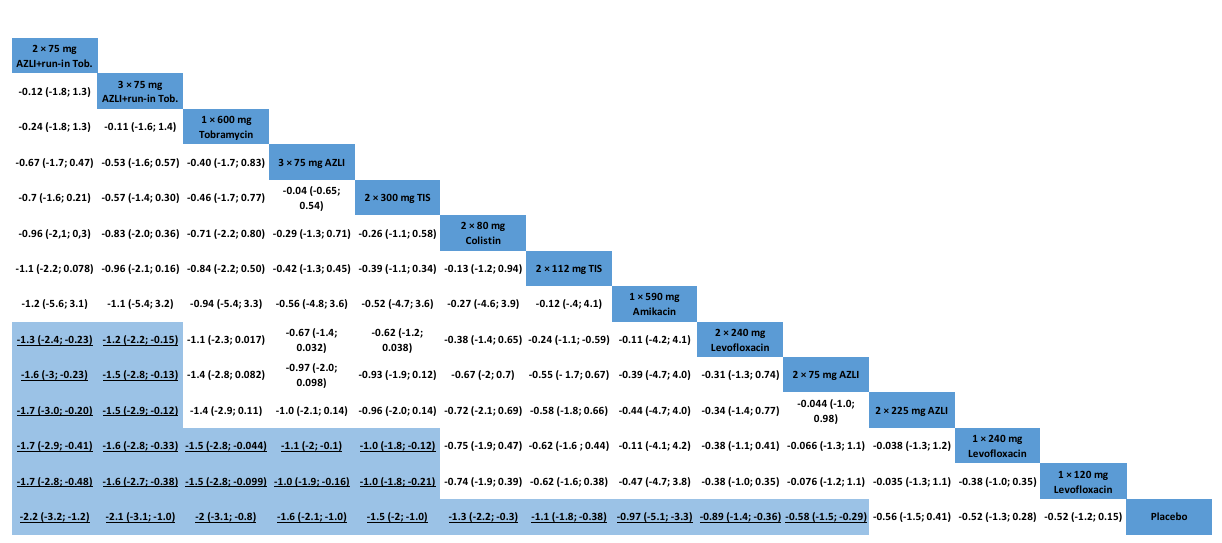
Figure 2. League table for change in Pseudomonas sputum density, log 10 CFU/g sputum (credible intervals). Blue boxes show significant differences. TIS = tobramycin inhalation solution, AZLI = aztreonam lysine, TIP = tobramycin inhalation powder, Col = colistin, LIS = levofloxacin, ALIS = amikacin inhalation solution.